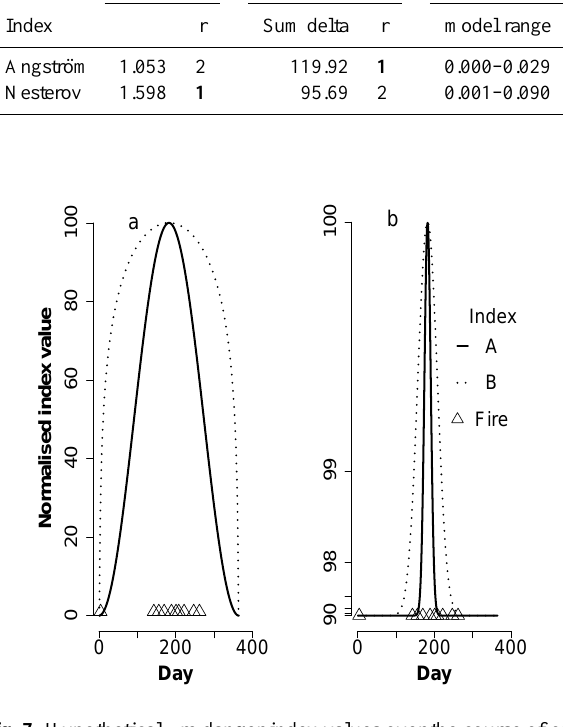
Fig. 7. Hypothetical fire danger index values over the course of one year, on linear (a) and exponential (b)